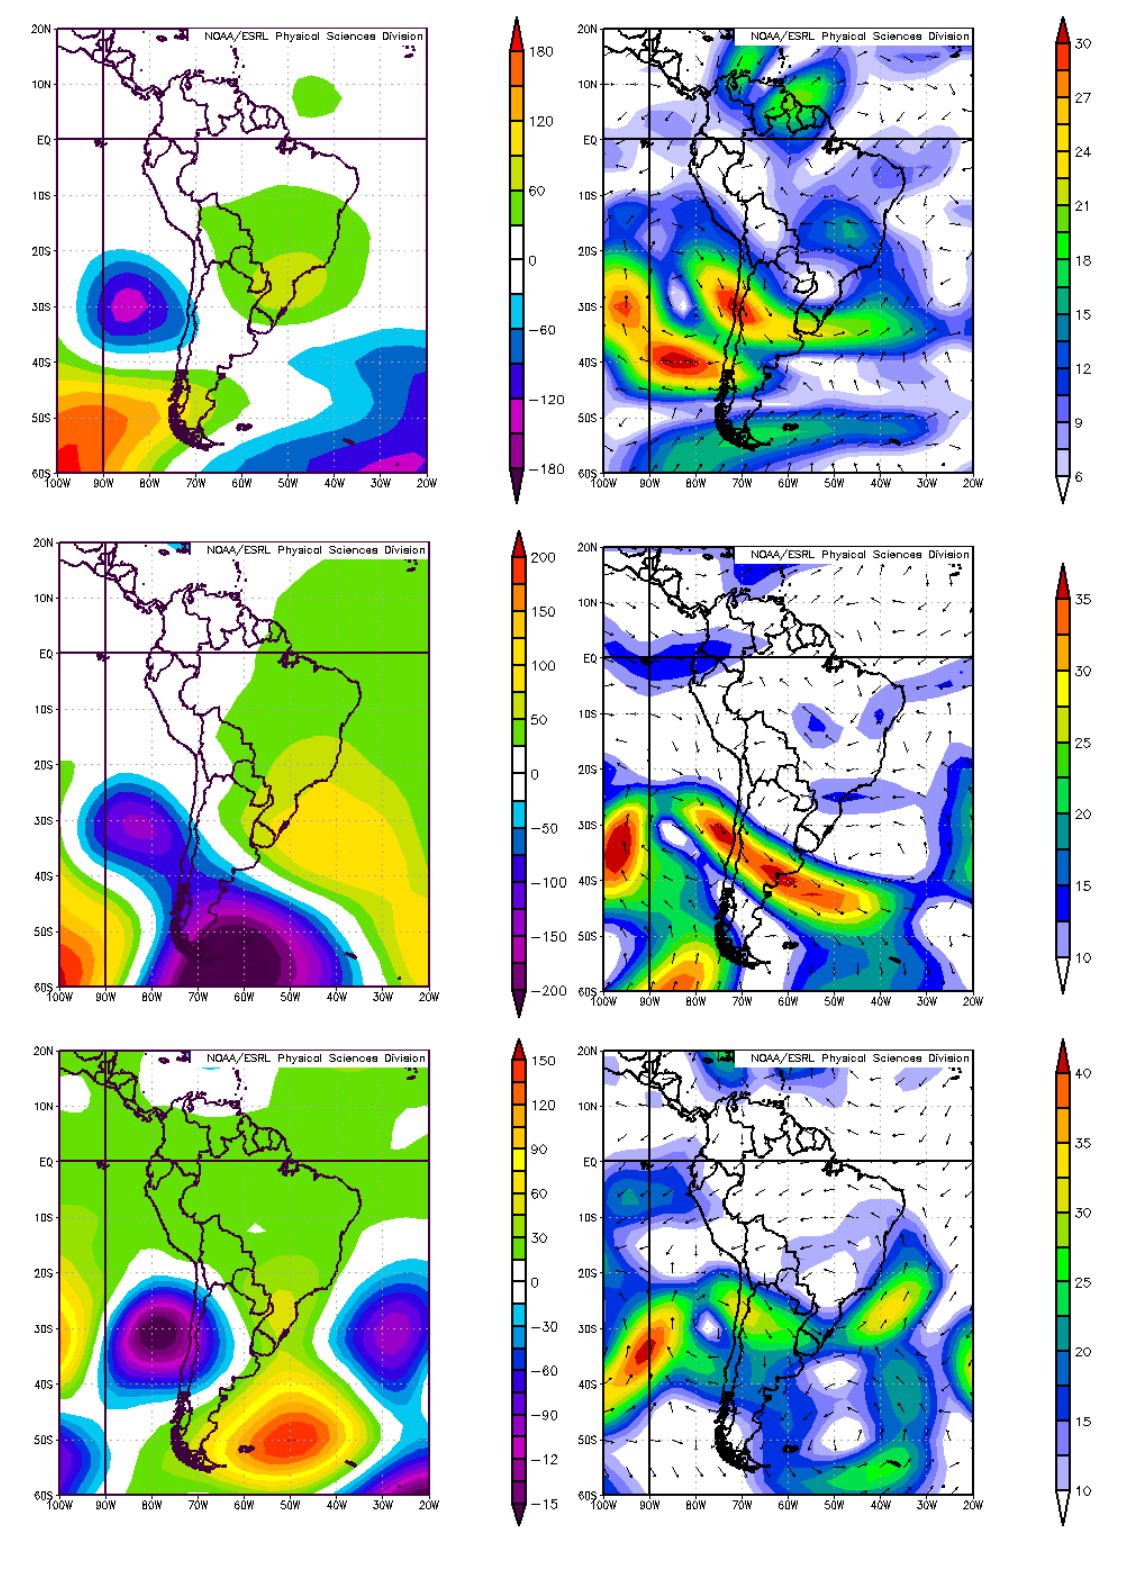
Figure 2. NCEP/NCAR Reanalysis composite anomaly for OCT15 ( upper row), APR16 ( middle row) and MAY17 ( bottom row) events, for 500 mb geopotential height (m) ( left column) and 250 mb vector wind (m/s) ( right